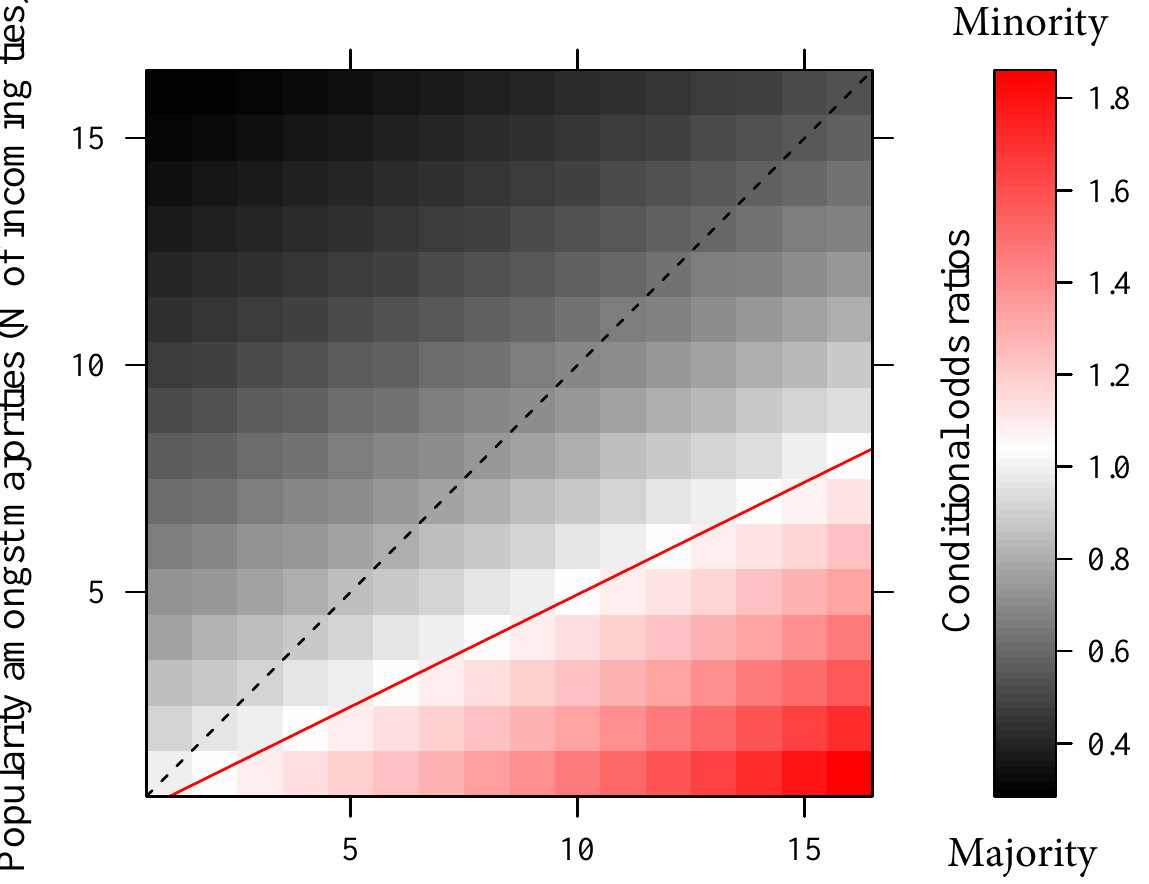
Figure 3: Classifications based on popularity amongst and activity towards majority